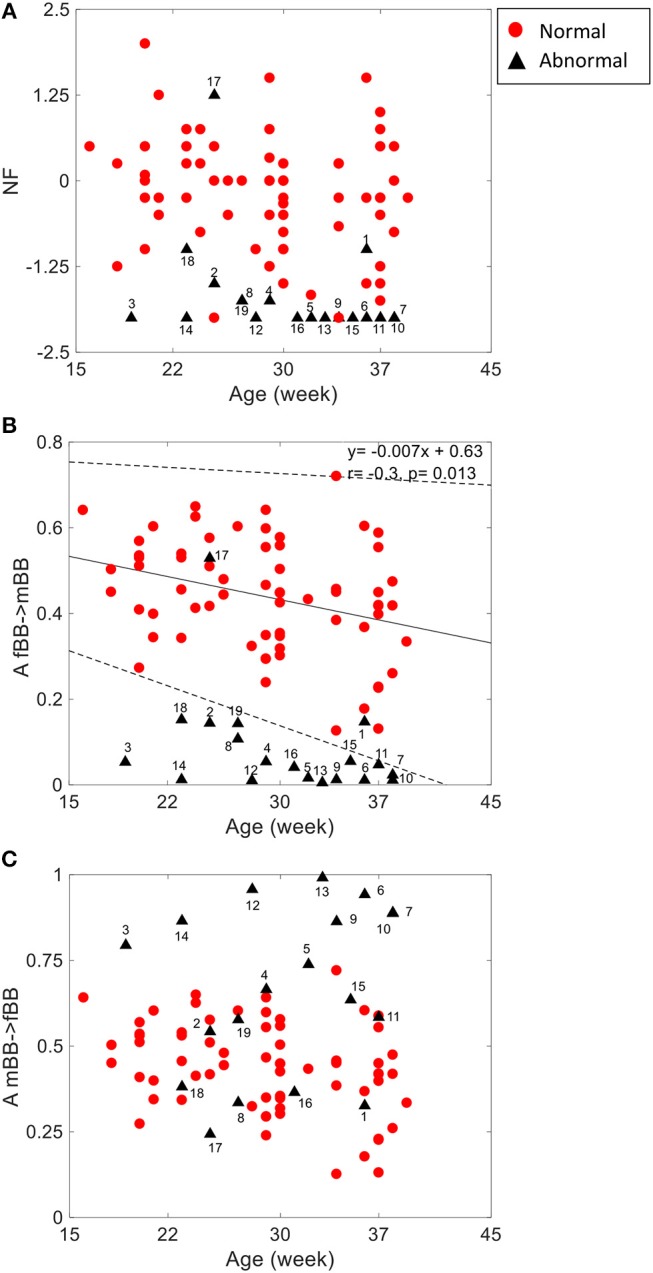
NSTPDC indices (NF: Normalization factor) (A), A_fBBI 1: N indicates the causal coupling strength originating from fBBI (fetus) toward mBBI (mother) (B) A_mBBI→fBBI indicates the causal coupling strength originating from mBBI (mother) toward fBBI (fetus) (C) vs. gestational age. The numbers indicate the ID of the abnormal cases. The coupling from fetus to mother for the normal group (B) showed a significant correlation with age (r = −0.3, p = 0.013). Solid line represents linear fit for the normal group and dashed lines indicate 95% confidence interval.